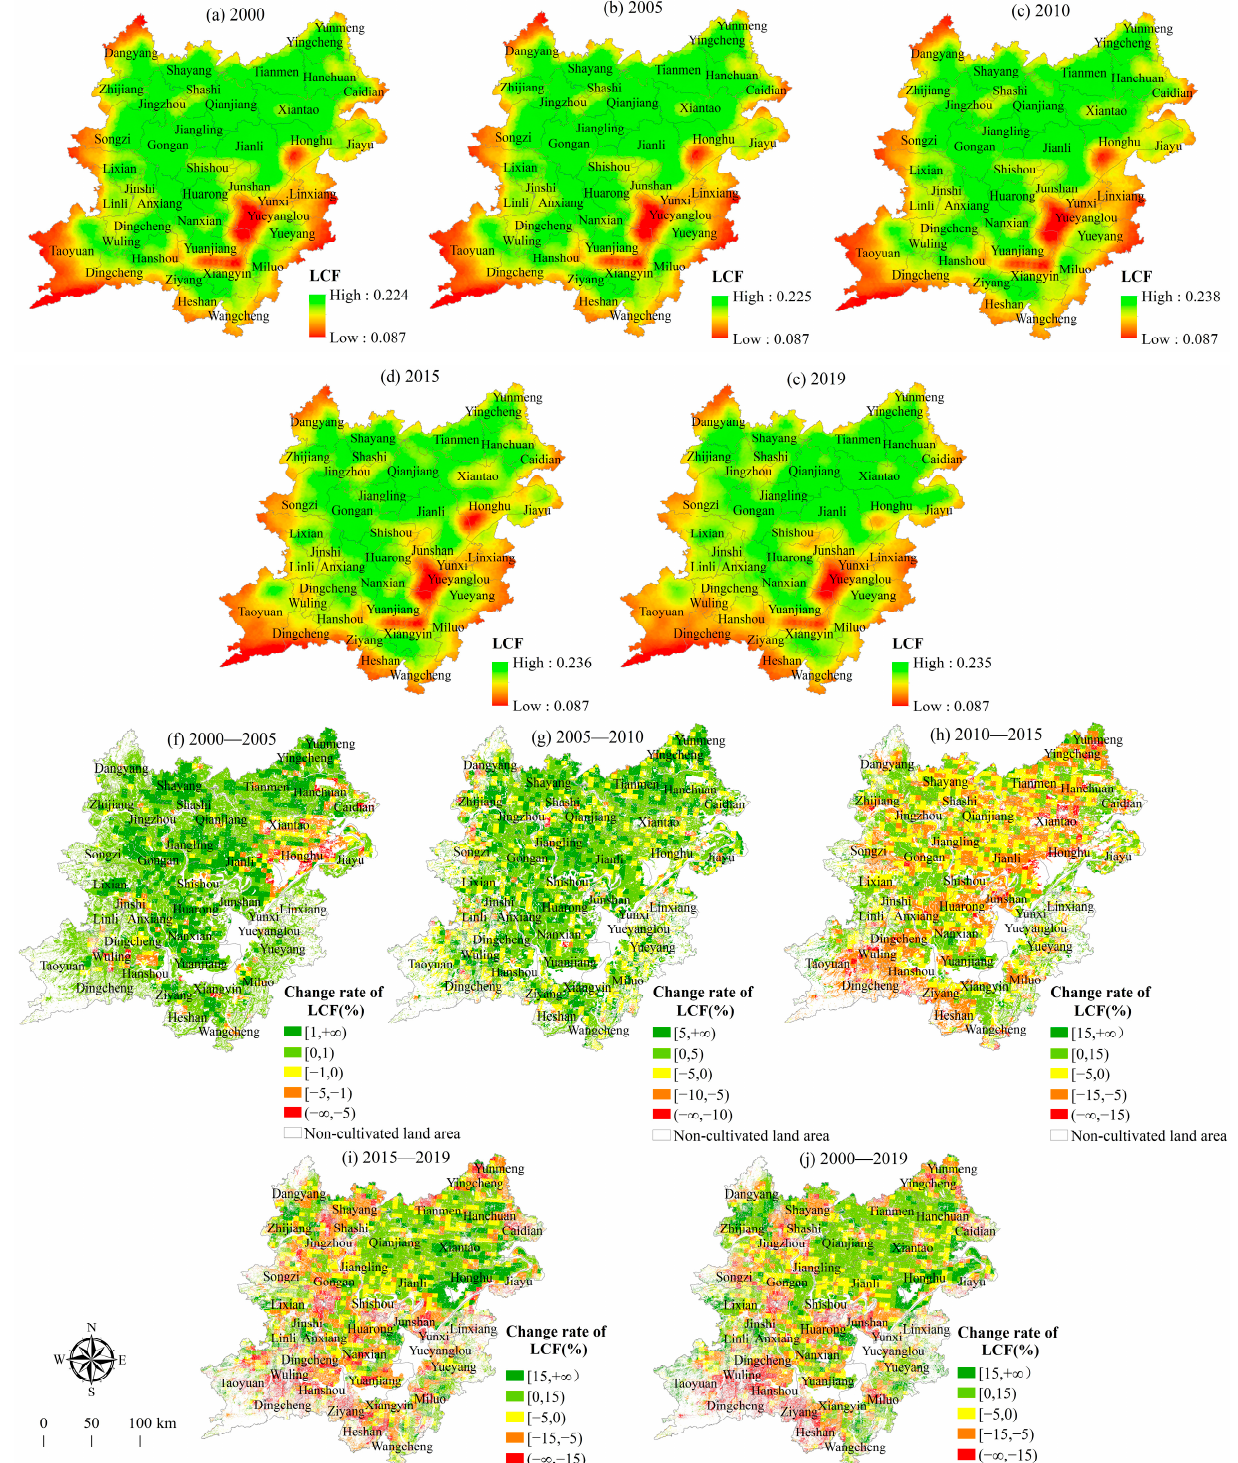
Figure 10. Spatial distribution of landscape carrying function